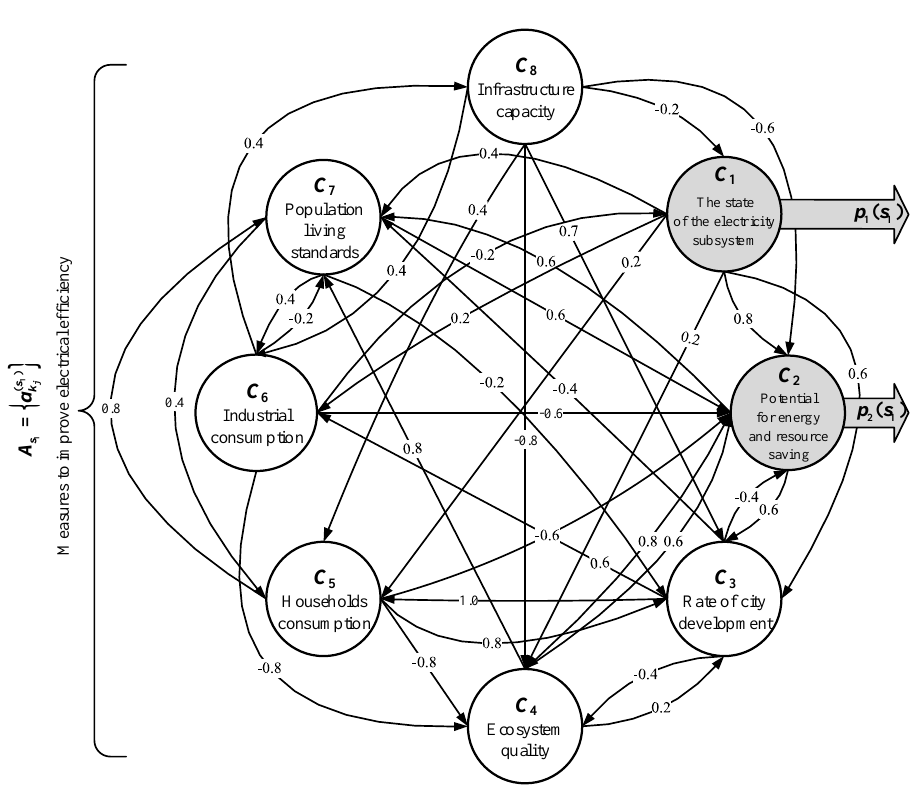
Figure 1. Structure of the compositional fuzzy model